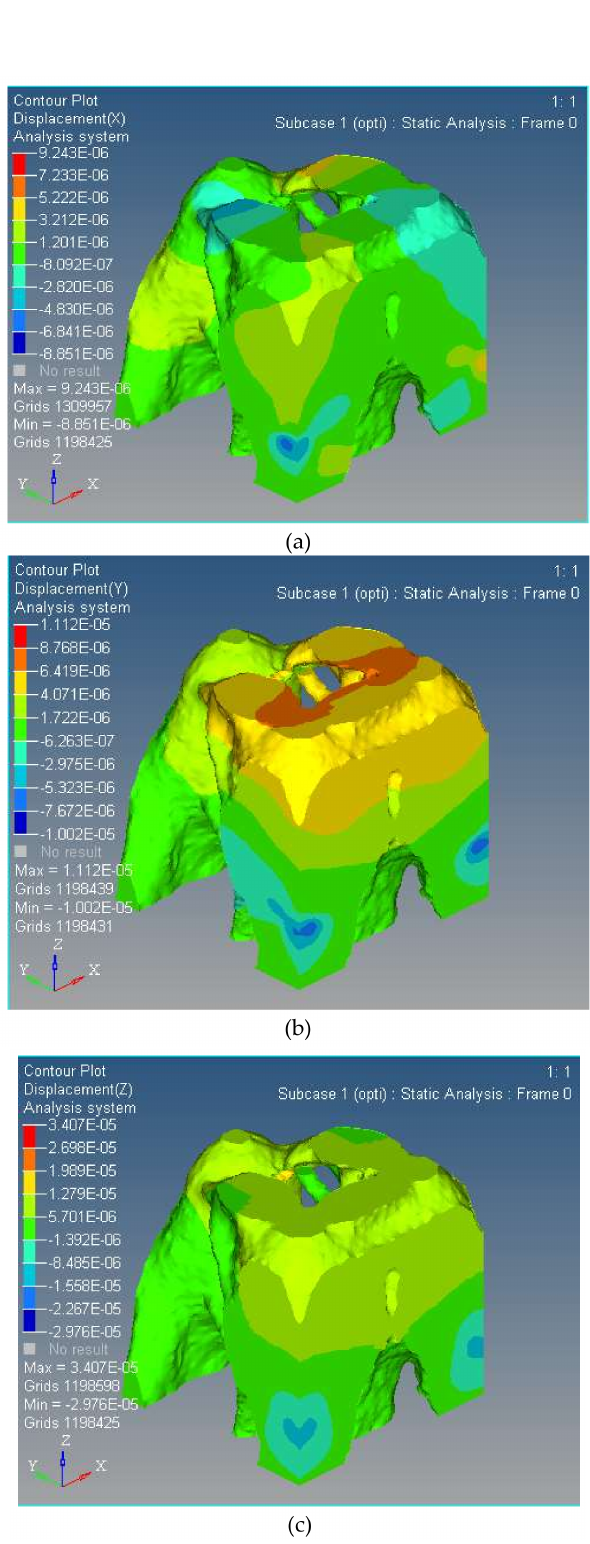
Figure 8. The three nano-scale-rotational displacements of the spatially compliant mechanism; ( a ) Along the x -axis the maximum displacement is 7.774 × 10 − 7 rad and the minimum displacement is − 6.299 × 10 − 7 rad; ( b ) Along the y -axis the maximum displacement is 3.541 × 10 − 6 rad and the minimum displacement is − 2.299 × 10 − 7 rad; ( c ) Along the z -axis the maximum displacement is 4.344 × 10 − 6 rad and the minimum displacement is 0